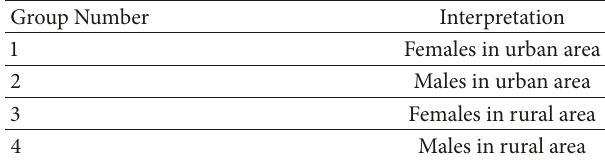
Table 4: Groups and their interpretations. Group